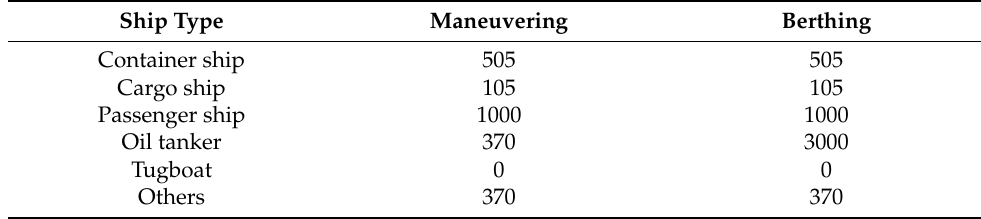
Table 8. Boiler load power for each ship type (unit: kw).